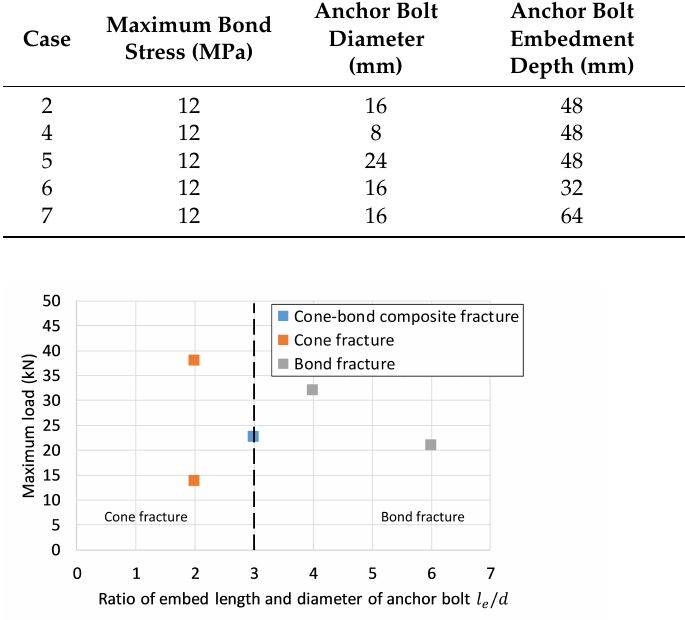
Figure 18. Classification of the pull-out fracture pattern of an anchor bolt.